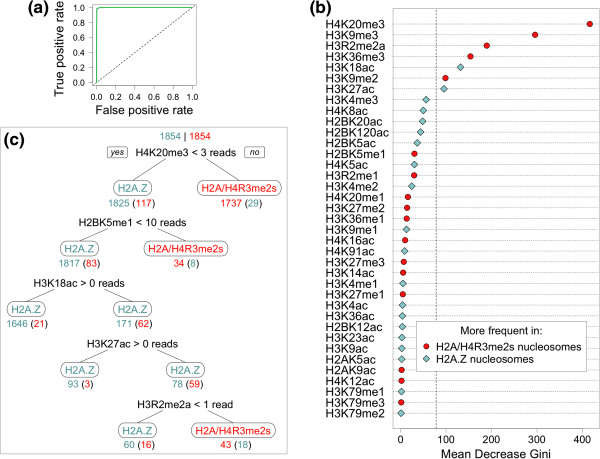
Classifying stable nucleosomes containing H2A/H4R3me2s or H2A.Z using histone modification features. (a) Receiver Operating Characteristic (ROC) curve, demonstrating classifier performance. (b) Random forests feature importance by mean decrease in Gini index. Features have a higher frequency in H2A/H4R3me2s nucleosomes (red) or H2A.Z nucleosomes (blue). The dashed, vertical line shows the estimated (permutation-based) significance threshold after multiple testing correction. (c) A classification tree with splits (no borders) and leaves (borders), below which is the number of nucleosomes classified correctly and, in parentheses, incorrectly at that stage. Leaves show the predicted class labels of nucleosomes partitioned there. Splits show the condition that best separates the data. Branch labels indicate the directions in which the split condition is true (“yes”) and false (“no”).